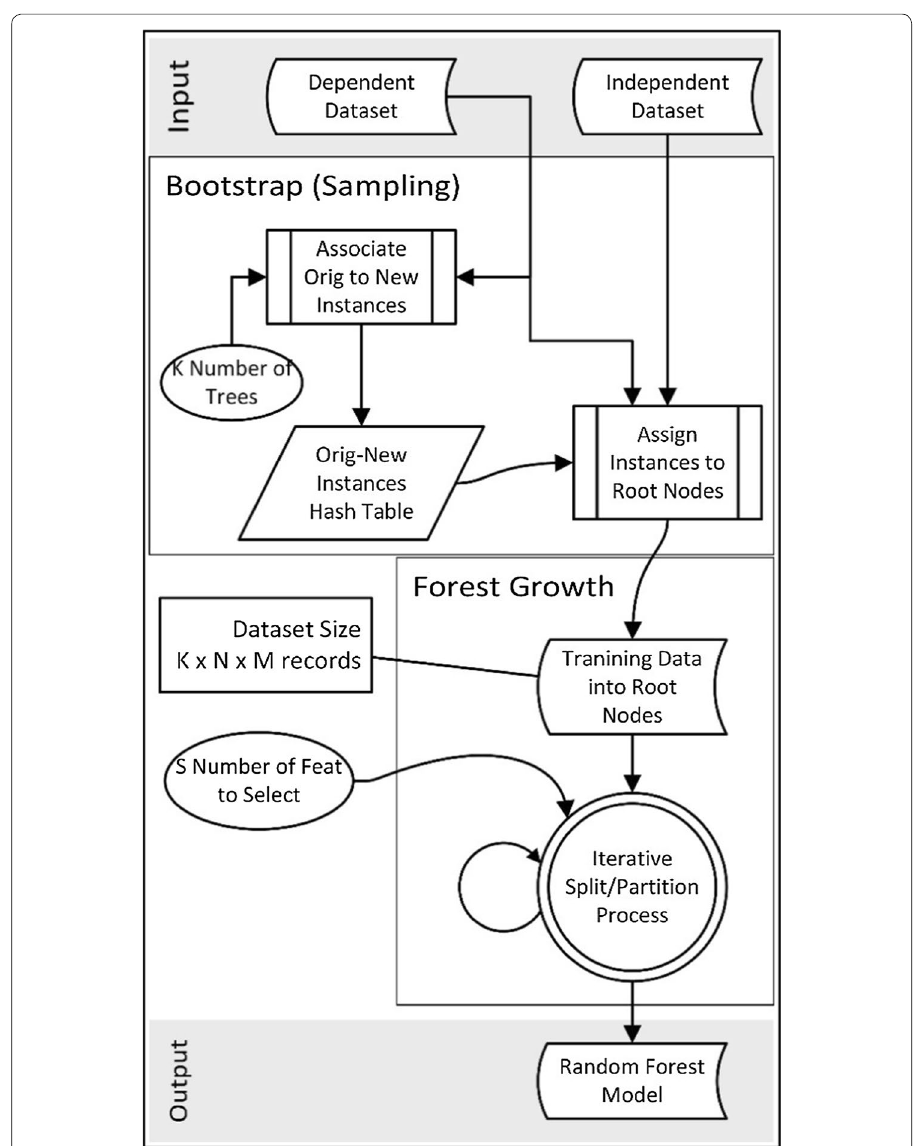
Fig. 5 Random Forest initial